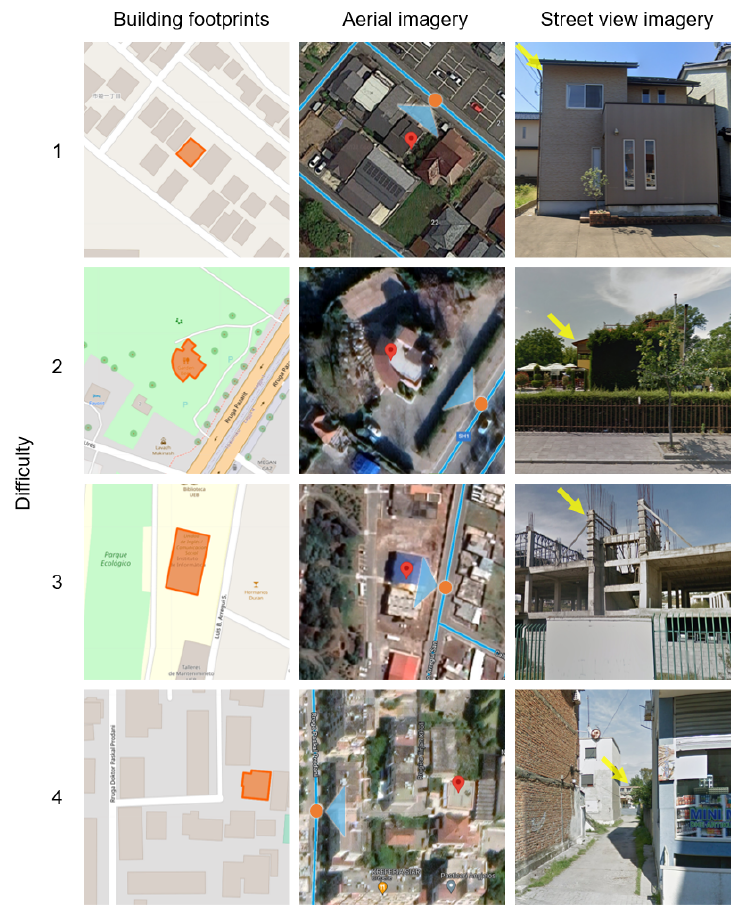
Figure 4. Examples of SVI studied and their interpretation difficulty levels. The OSM building footprints highlighted in orange (first column) are some of those that we randomly selected around the world. The orange point in the Google Maps’ aerial imagery represents the street view point with its corresponding image to the right. Images are courtesy of © OpenStreetMap contributors, Google Maps, and Google Street